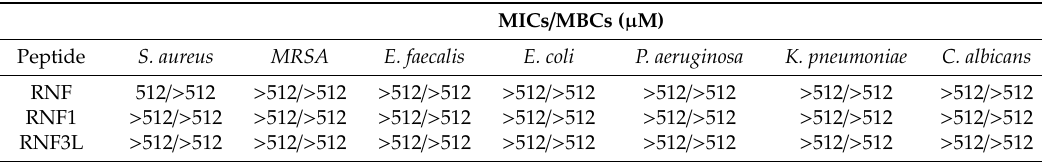
Table 2. Antimicrobial activity of RNF and its